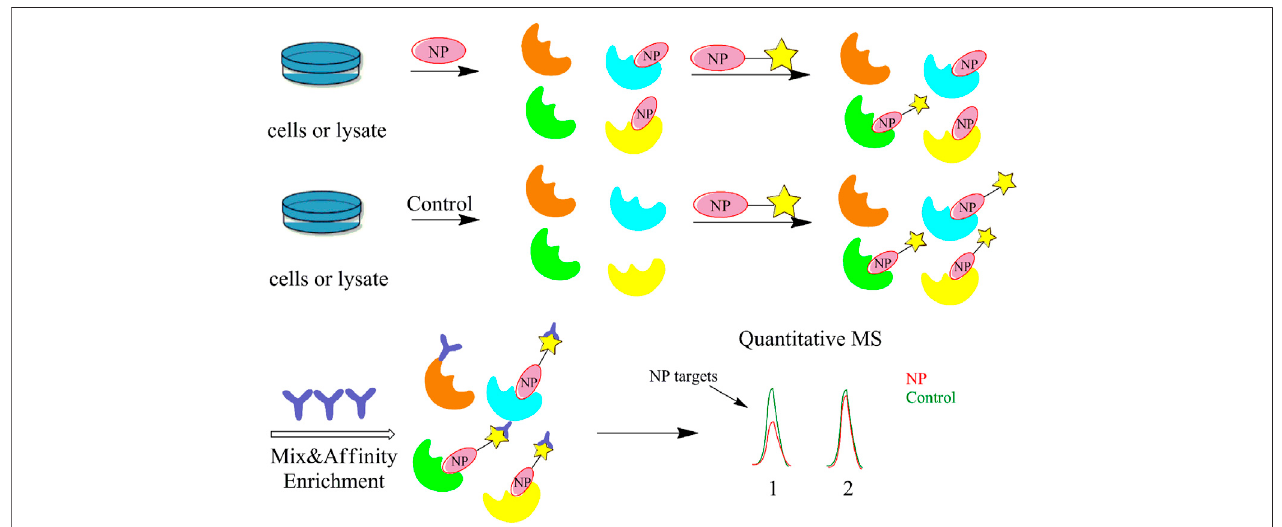
FIGURE5| Flowdiagramofthecompetitiveactivity-basedproteinpro fi ling(ABPP)strategy.Itallowstheprecursorcompoundoftheprobetobeco-incubatedwith theproteomebeforeaddingtheprobetobindwiththeprotein.Then,itispossibletoobtainthetruetargetproteinbycomparingtheproteinandactivesitelabelledbythe probe before and after the addition of the precursor